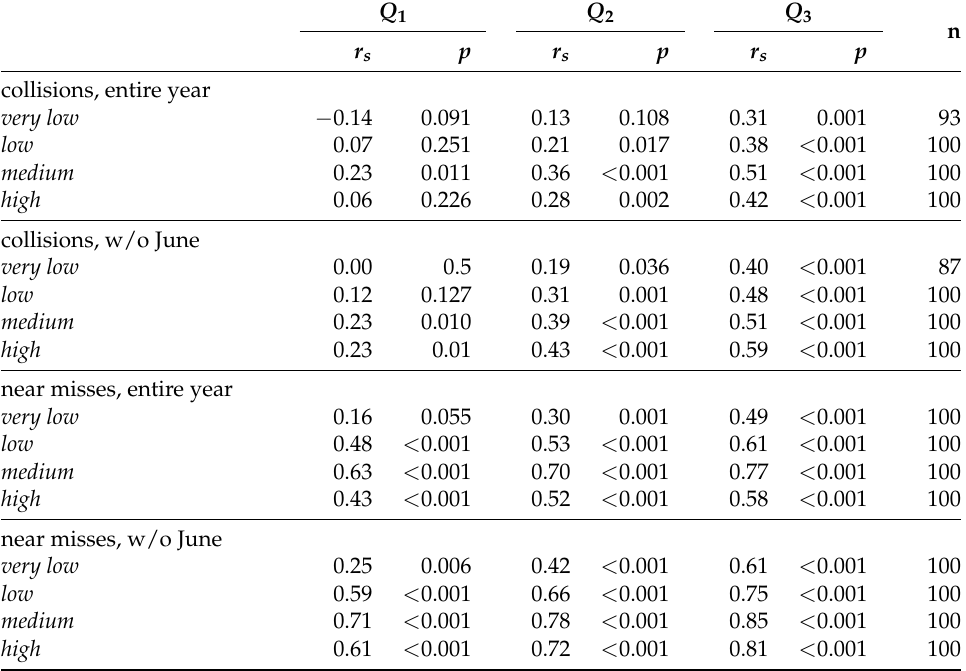
Table 7. Boxplot values regarding the correlations between number of birds and number of collisions/near misses for the different traffic volumes ( Q 1 – Q 3 : boxplot quartiles; r s : Spearman correlation, p : one-tailed p